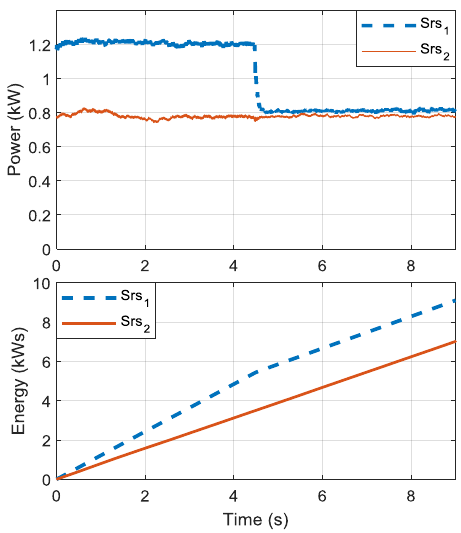
Figure 12. Power and energy supplied by Src1 and Src2 in case study II .